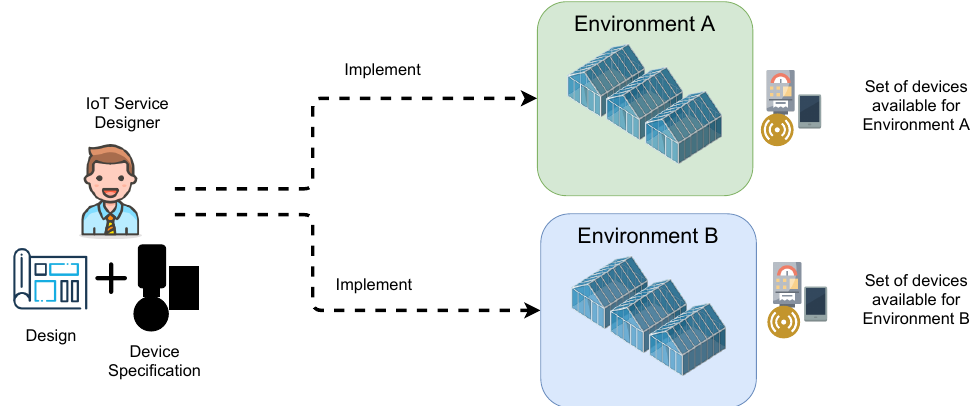
Figure 8. The concept of Design Once, Provide Anywhere . The service can be implemented with one service design and only specify the required devices’